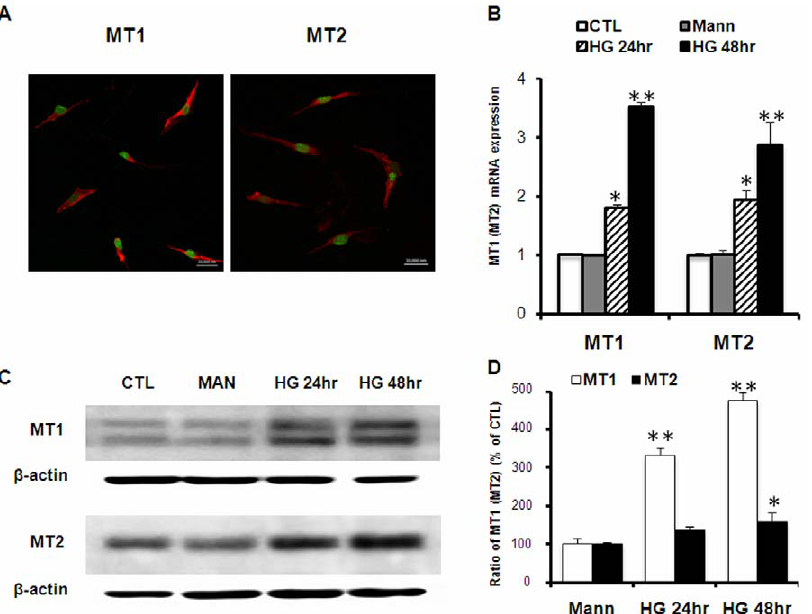
Figure 1. High glucose-induced upregulation of melatonin receptors in Mu¨ller cells. (A) Immunostaining of MT1 and MT2 in cultured primary rat Mu¨ller cells. Nuclei were counterstained with SYTO green, Scale bar=20 m m. (B) High glucose-induced mRNA expression of both melatonin receptors. Cells were treated with 30 mM glucose for 24 and 48 hr. MT1/MT2 expression was measured by Real-time RT-PCR and normalized to b -actin mRNA. CTL: untreated control; Mann: 24.5 mM mannitol as osmolarity control. (C) Western blot of MT1/MT2 proteins in Mu¨ller cells treated with high glucose. (D) Quantification data from the Western blots after normalizing to b -actin. Data presented are the average from 3 to 5 separate experiments (mean 6 SD). *P , 0.05, **P , 0.01, as determined by either one-way ANOVA (B) or Student’s t-test